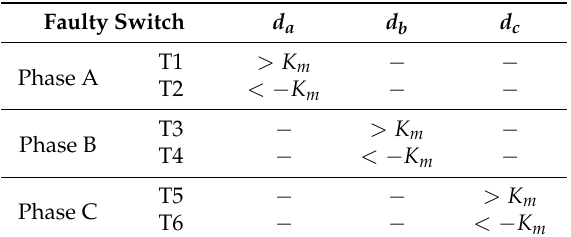
Table 1. Detect of single open circuit